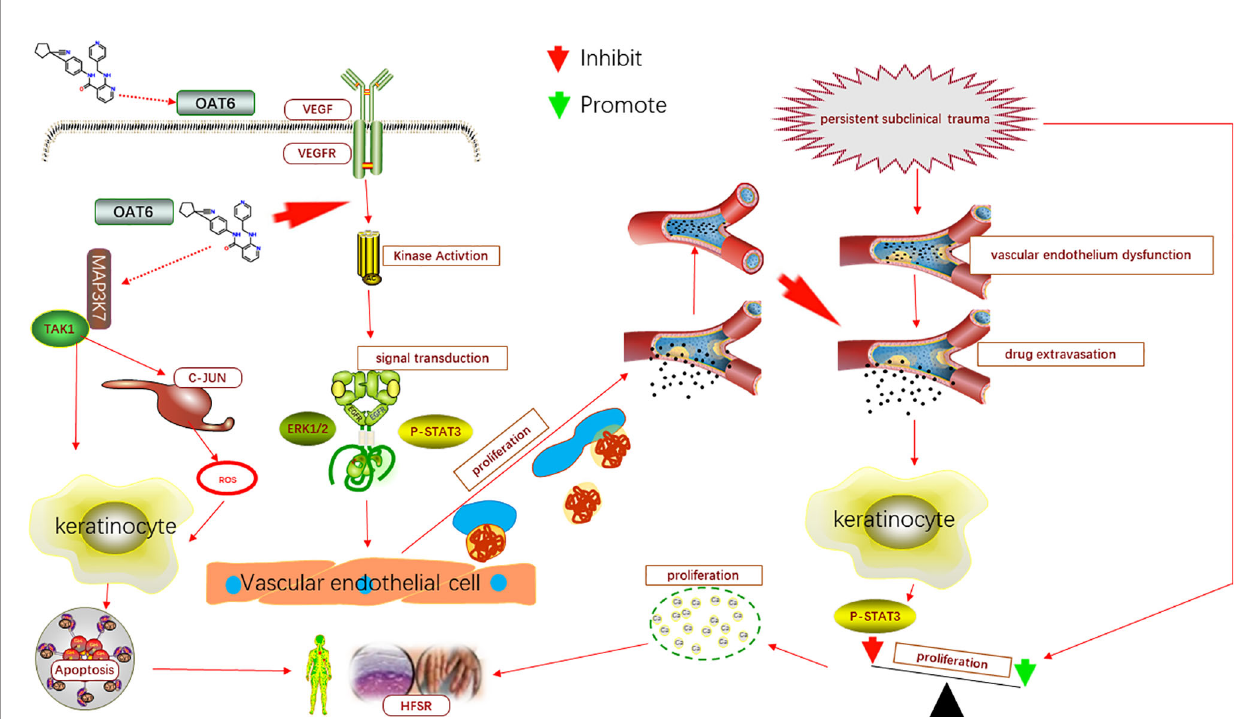
FIGURE 1 | The model of AI-HFSR in liver cancer. By impeding the reparation of capillary, apatinib may cause the in fl uence of subclinical damage persistence, which in turn, contribute to the over proliferation of keratinocytes; Apatinib might be uptaken by OAT6 on membrane of keratinocyte, and promote the apoptosis of keratinocyte per